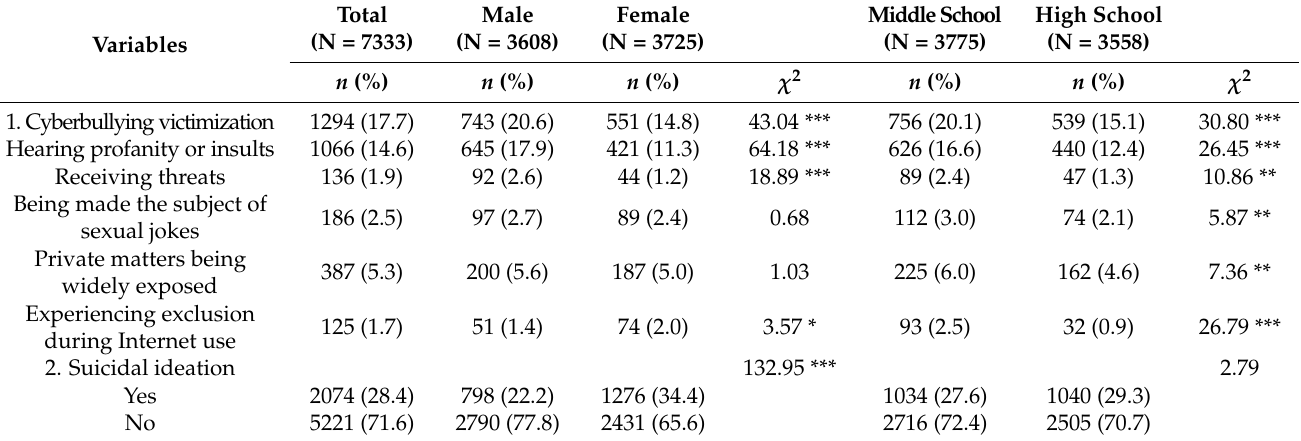
Table 1. Prevalence of cyberbullying victimization and suicidal ideation among Korean